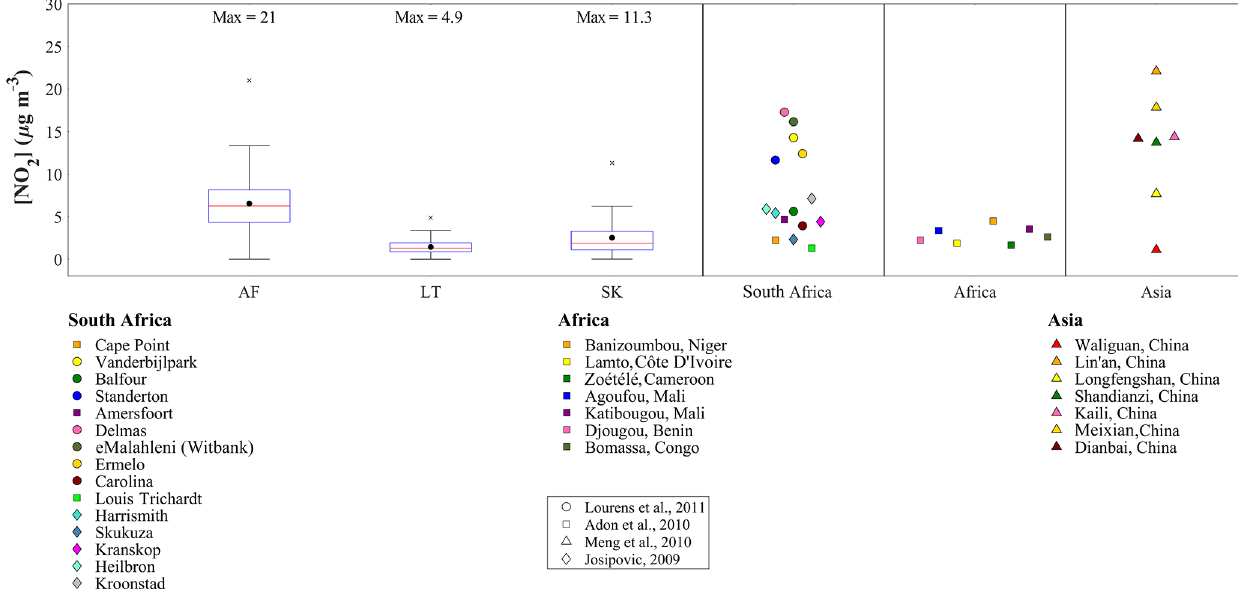
Figure 13. Statistical spread of NO 2 concentrations determined during the entire measuring period at each site compared to mean levels determined with passive samplers elsewhere. The red line of each box represents the median; the top and bottom edges of the box represent the 25th and 75th percentiles, respectively; the whiskers are ± 2 . 7 σ (99.3% coverage if the data have a normal distribution); and the black dots represent the average